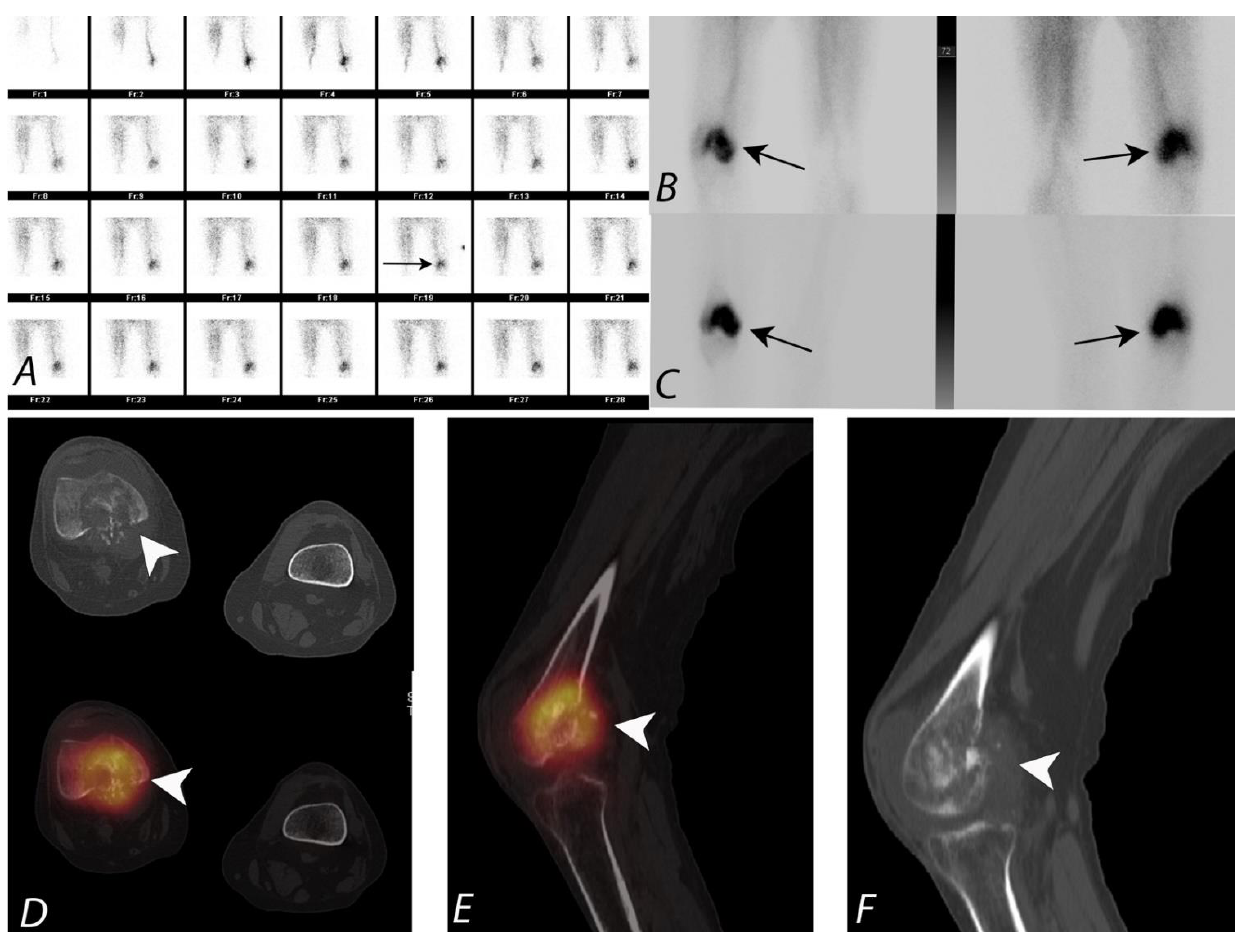
Figure 5. Twenty-year-old male patient presenting with right knee pain. Plain radiograph demonstrated a lesion suspicious for osteosarcoma involving the distal femoral shaft (Not shown). Patient underwent three phase 99m Tc MDP bone scan as a part of staging. Blood flow images ( A ) in posterior projection demonstrated asymmetrically increased blood flow to the right distal femoral region (black arrow). Blood pool and delayed images ( B , C ) also demonstrated increased pool activity and delayed accumulation of activity, correlating with the region of increased vascularity noted on blood flow images (black arrows). Axial CT and fused SPECT/CT ( D ), sagittal fused SPECT/CT ( E ) and sagittal CT images ( F ) images localize the activity to right distal femoral condyle predominantly lytic lesion associated with osteoid matrix. There is posterior cortical destruction, associated with soft tissue extension of the tumor posteriorly, which also demonstrates activity within (white arrowheads). Small knee joint effusion is also seen.